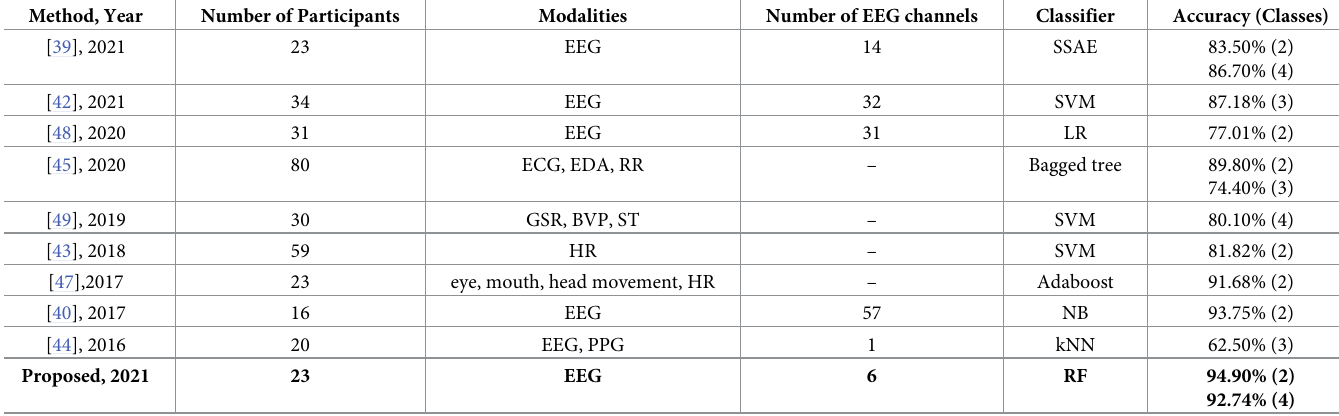
Table 6. Performance comparison of the proposed framework with the state-of-the-art methods for human state anxiety